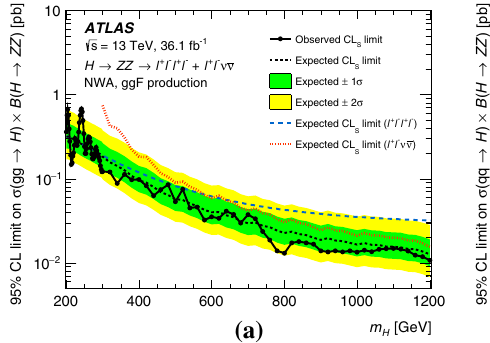
boson to vector bosons is proportional to cos (β − α) . In the limit cos (β − α) → 0, the light CP-even Higgs boson is indis- tinguishable from a SM Higgs boson with the same mass. In interpretations are presented. Figure8shows exclusionlimits inthetan β versus cos (β −